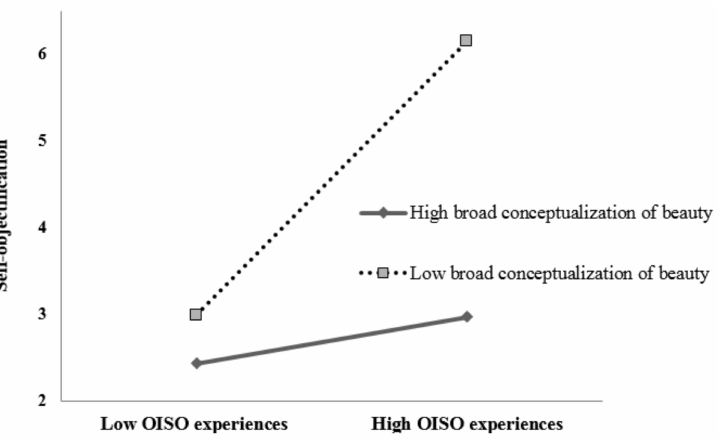
Figure 1. Moderating effect of broad conceptualization of beauty in the relationship between OISO experiences and